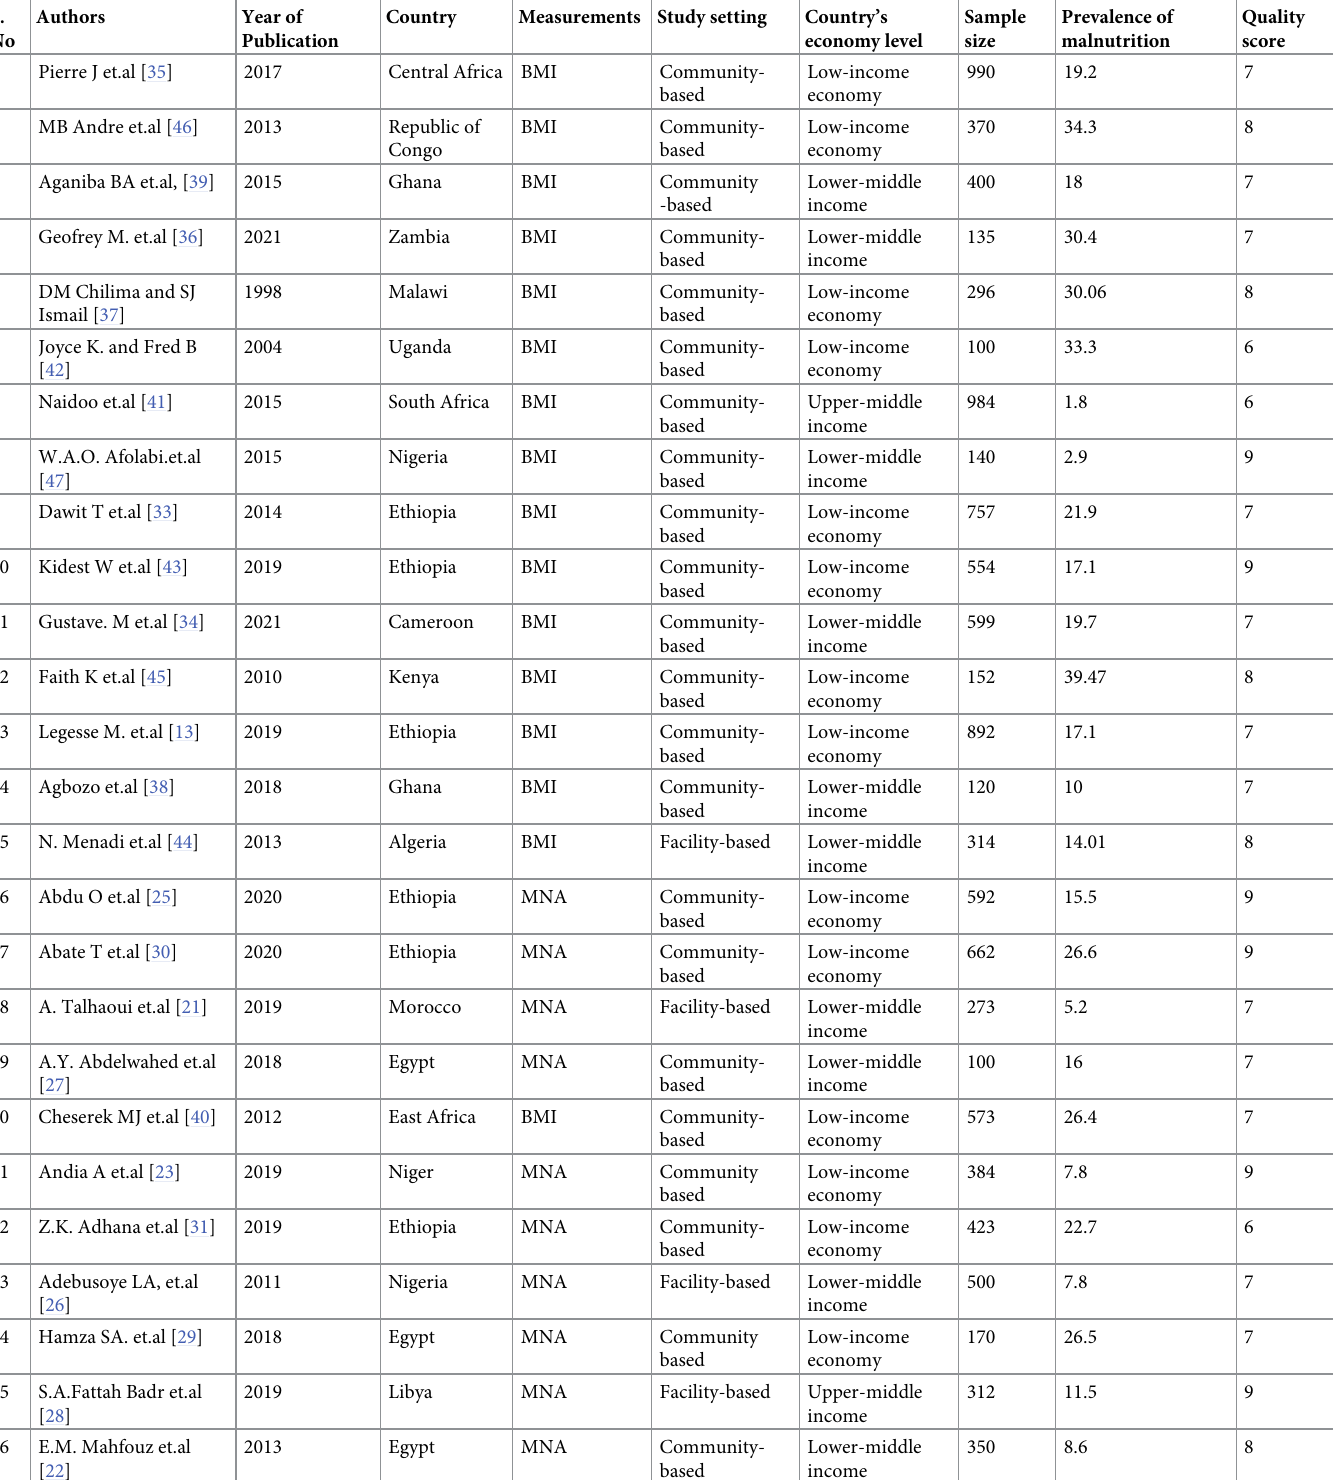
Table 1. Summary of the characteristics of included studies in the